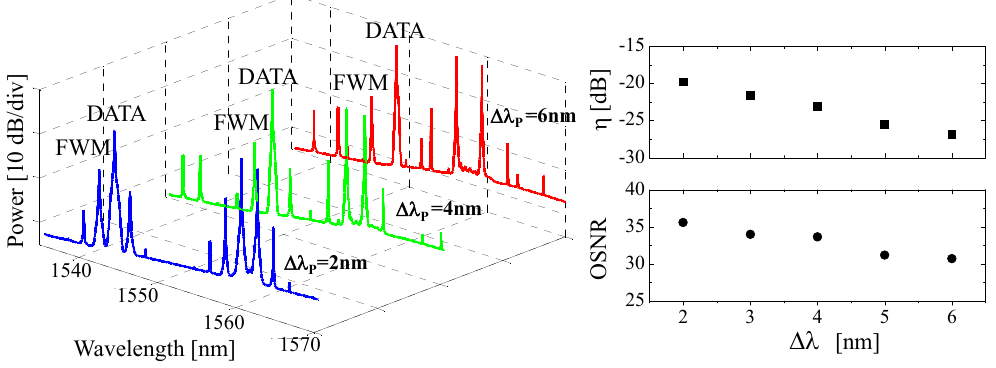
Figure 3. ( left ) Optical spectra at semiconductor optical amplifier (SOA) output for different pumps detuning; ( right ) FWM conversion efficiency ( ŋ ) and optical signal-to-noise ratio (OSNR), vs. the conversion span when input is polarized TE.